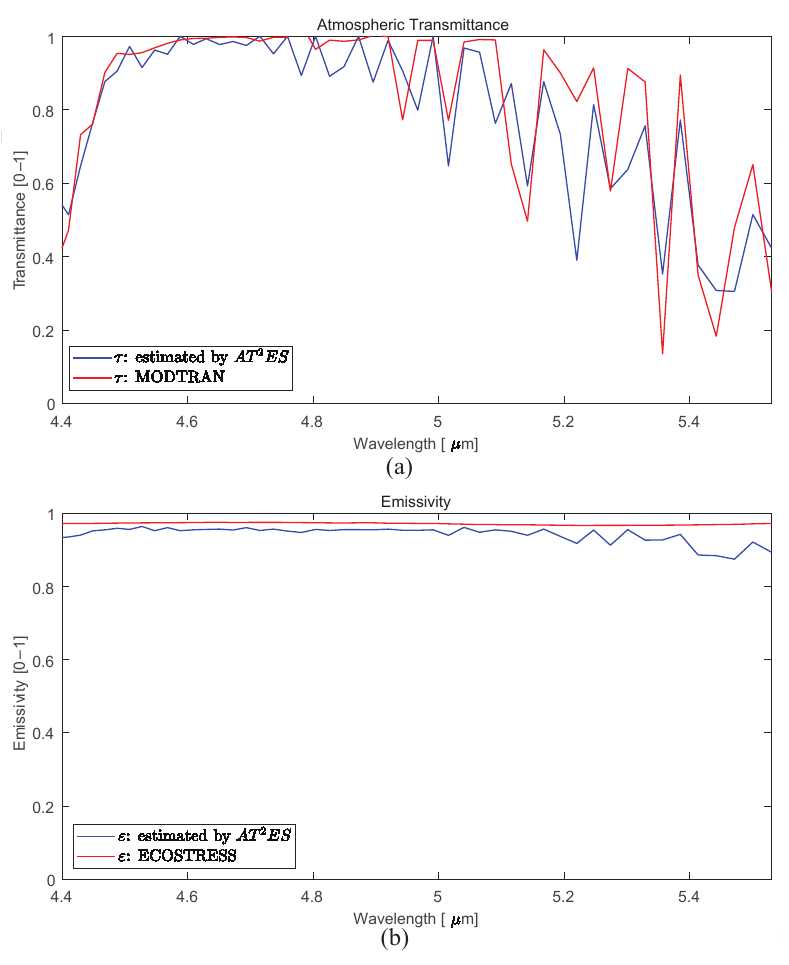
Figure 24. Grass region: Comparison of atmospheric transmittance and emissivity estimation by the proposed AT 2 ES : ( a ) spectral atmospheric transmittance comparison with MODTRAN, and ( b ) spectral emissivity comparison with the ECOSTRESS library.